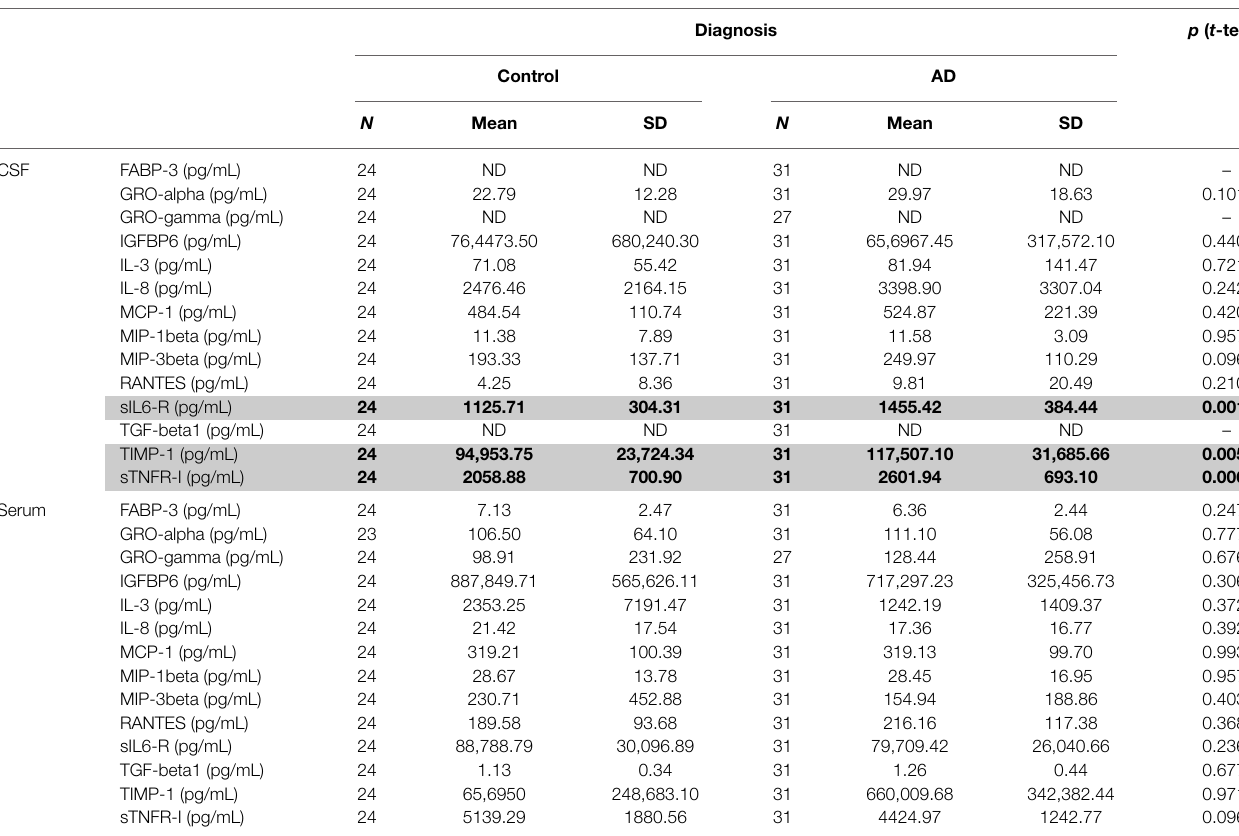
TABLE 2 | CSF and serum quantification of predictors identified